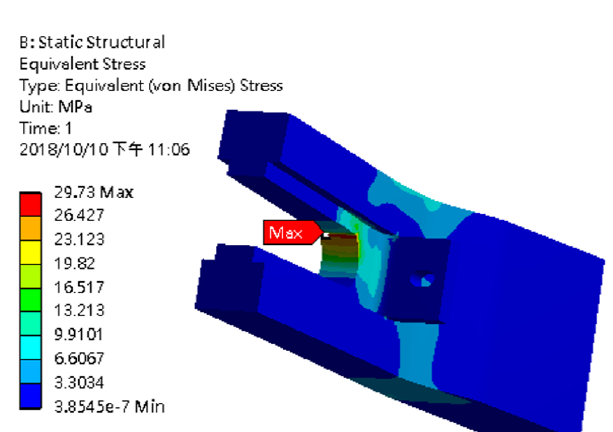
Figure 30. Rear wheel axle fastener stress pattern.